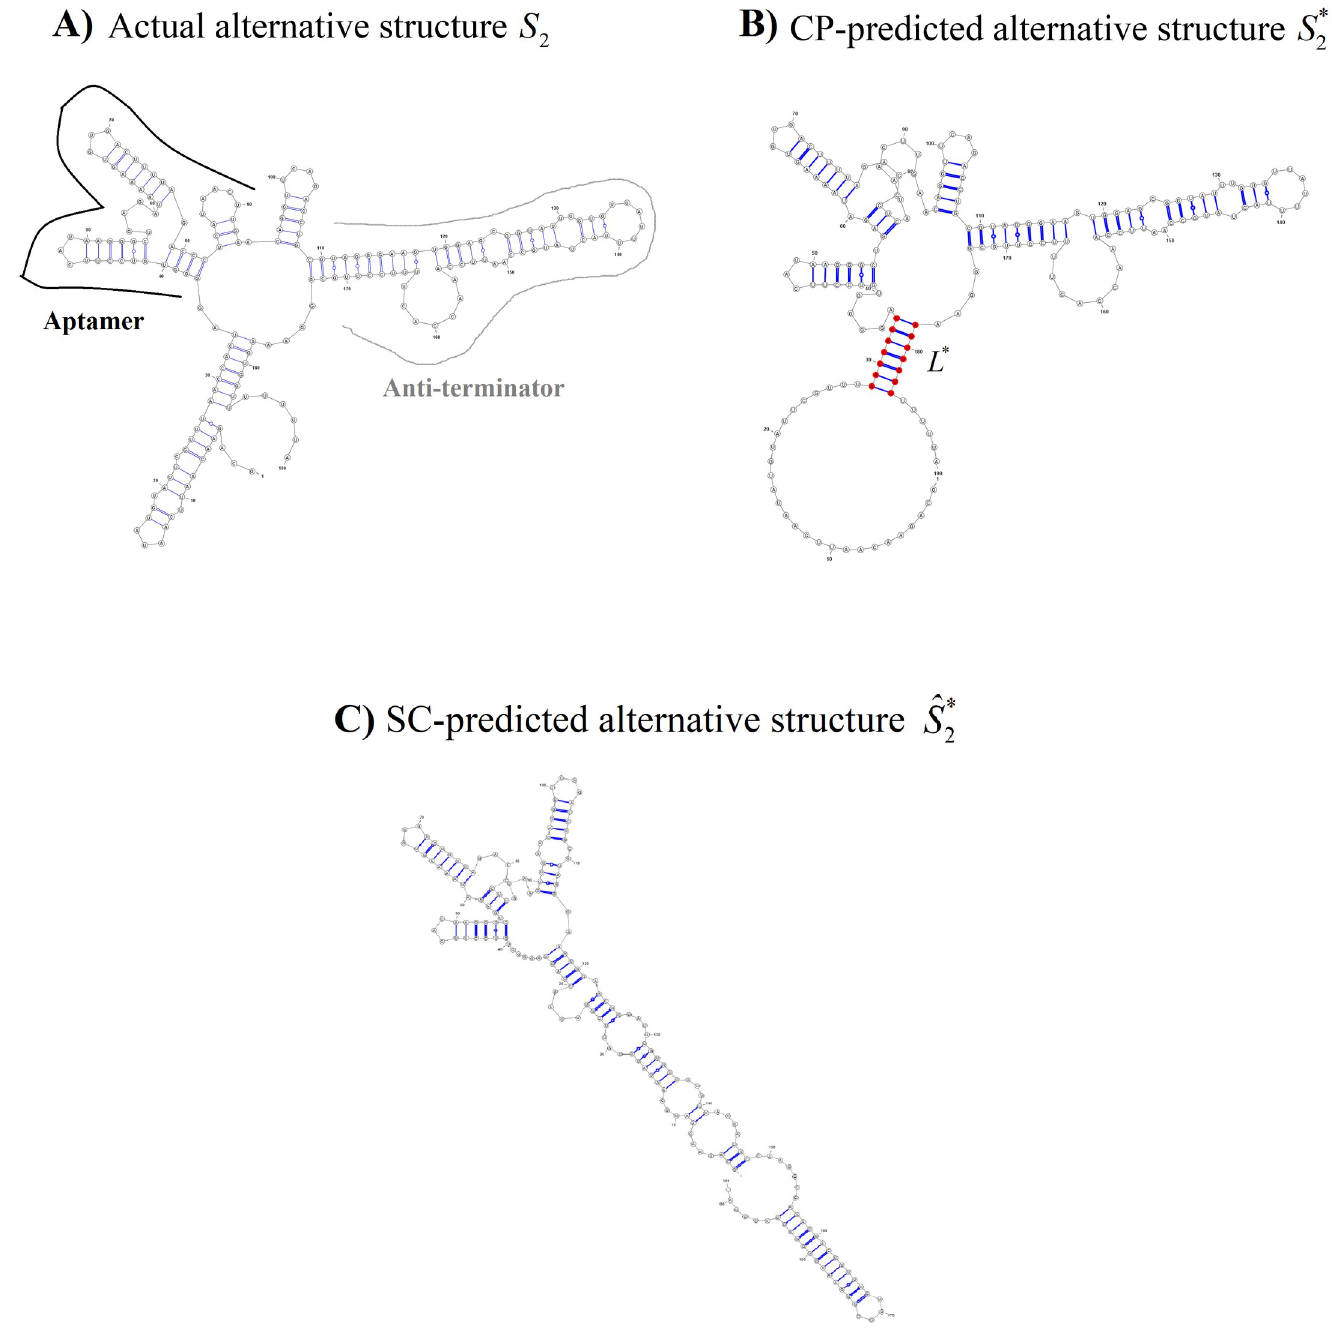
Fig 2. Prediction of the alternative structure of tenA TPP riboswitch. Sequence length in the Barsacchi Dataset was 190nt. A) The actual alternative structure S 2 (here, the unbound state), with the approximate locations of the aptamer substructure and the anti-terminator stem as indicated. B) The CP-predicted alternative structure S � . The stem seed L � = {28 ... 34 � 178 ... 184} is shown in red. C) The SC-predicted alternative structure ^ S � 2